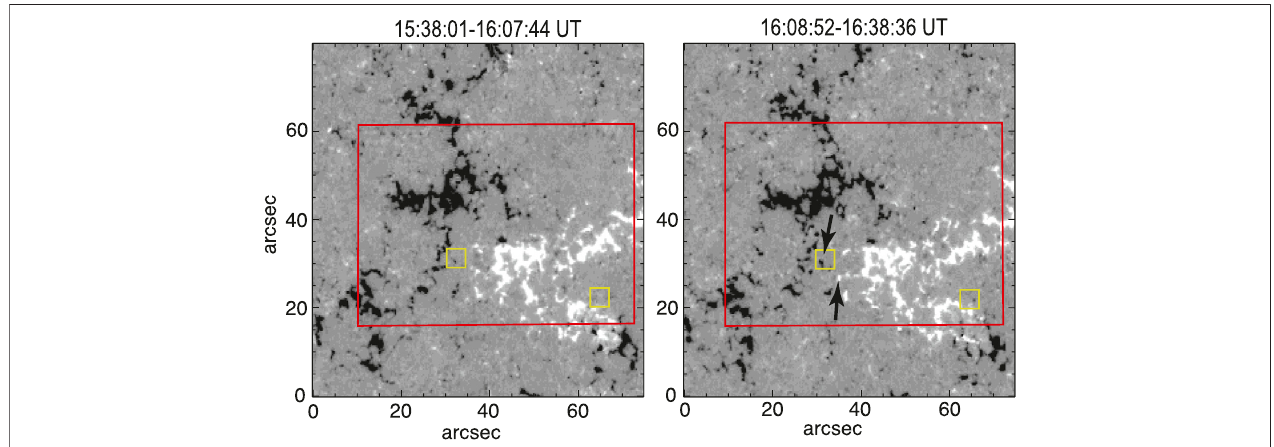
FIGURE 4 | Stokes V amplitude maps from two Hinode/SOT Spectro-Polarimeter ’ s scans during the ALMA observing period. The fi eld of view is 75 × 80 arcsec, wheretheslitismovedfromthelefttotheright.Theleftmapwasrecordedfrom15:38:01-16:07:44UTandtherightfrom16:08:52-16:38:36UT.Theredrectanglegives the fi eld of view used in Figure 1 . The yellow squares are the location of two macro-pixels where large variations exceeding 200 K are observed. The arrows specify newly appeared magnetic fl ux patches.